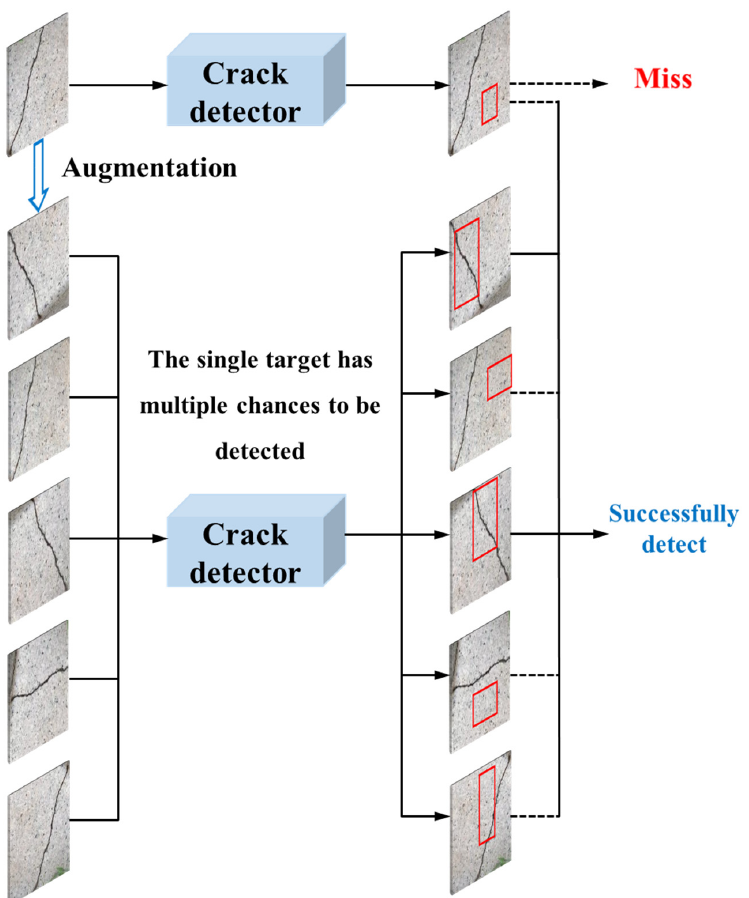
Figure 4. Data augmentation in the inference process. The crack obtains multiple chances to be detected in multiple augmented images when processing an actual image. If one crack is detected in any image after data augmentation, it is considered to be detected successfully.